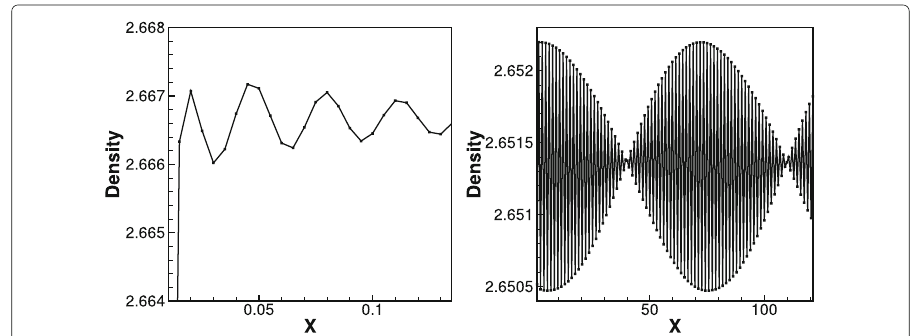
Fig. 2 Zoomed density distribution (left) downstream of the shock wave and the time evolution of density at the point x = 0.01 (right) of the 1D steady shock wave with Mach number M ∞ = 2.